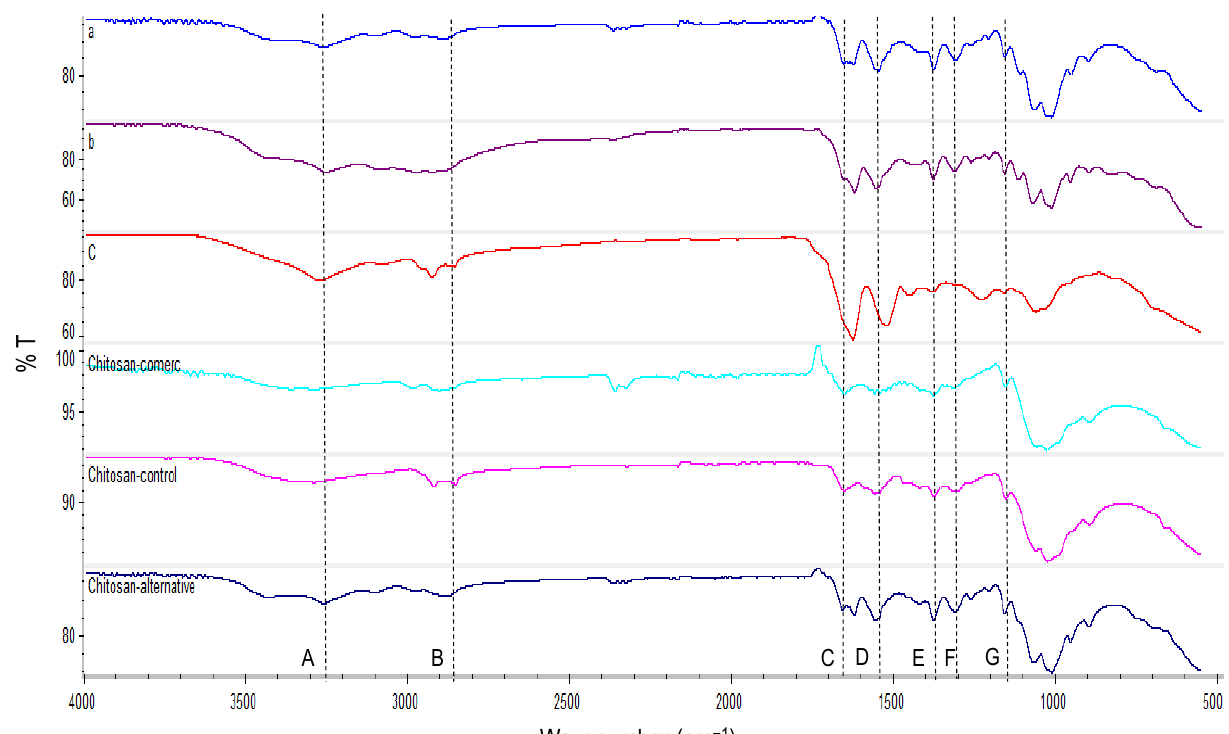
Figure 4. FTIR spectra of commercial chitin (a), chitin obtained from cricket flour by the chemical method (b), chitinous material obtained from cricket flour by the biological method (c), chitosan produced from commercial chitin (chitosan-commerc.), chitosan produced from chitin extracted from the cricket flour by the chemical method (Chitosan-control) and chitosan produced from chitin extracted from the cricket flour by the biological method (Chitosan-Alternative). A–G are the characteristic bands.